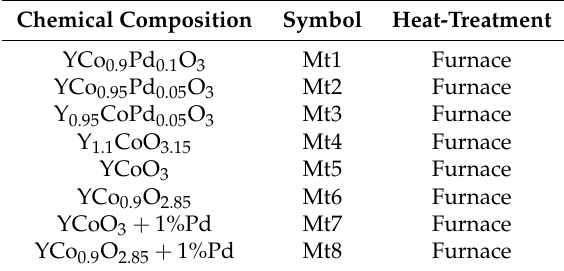
Table 1. Gas sensing materials: Chemical composition, symbols and